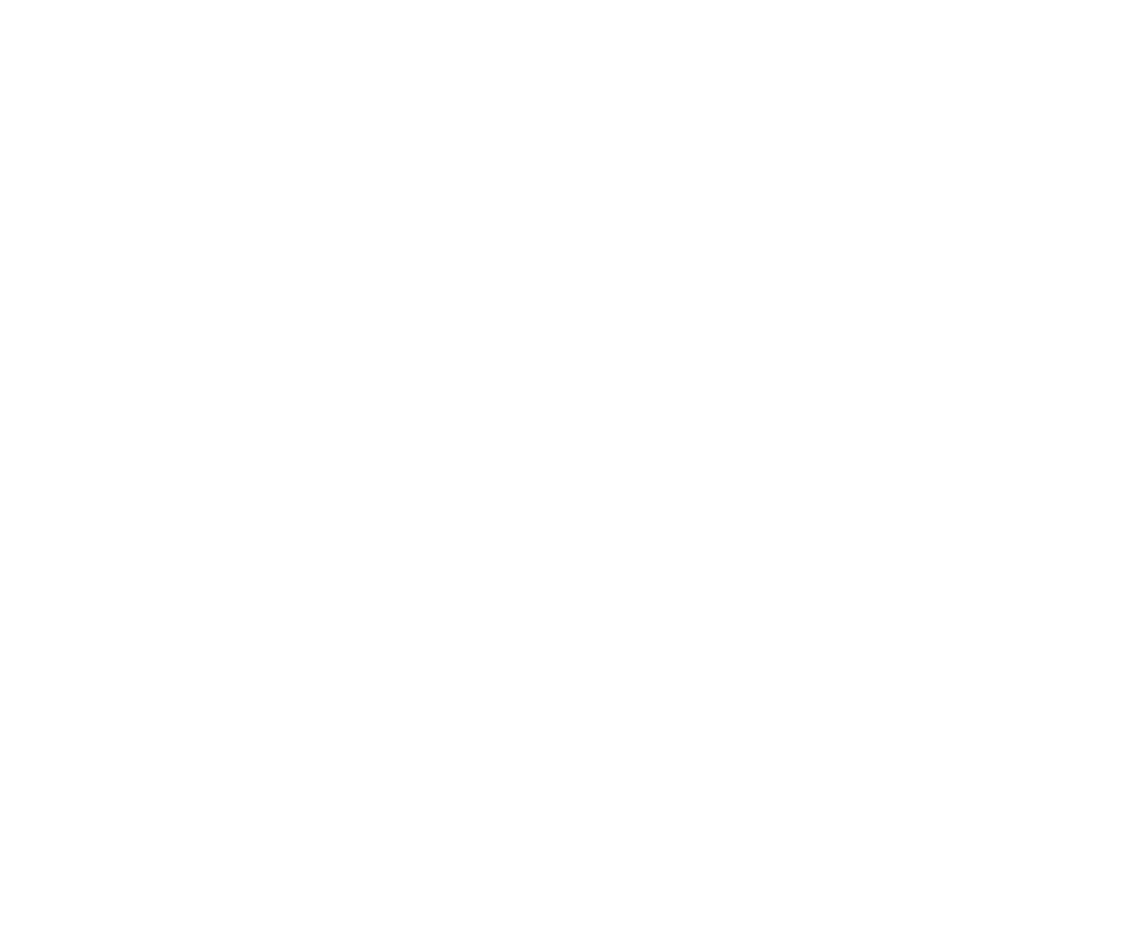
FIGUREA1 | Outline of the experimental schedule. After 1week of acclimation, baseline behavioral analyses, and injury (or sham), rats were treated intraperitoneally for four consecutive days (marked by circled numbers of 1 through 4) with 50mg/kg of minocycline or saline starting at 4hours after injury. Behavioral assessments (Open Field, Elevated Plus